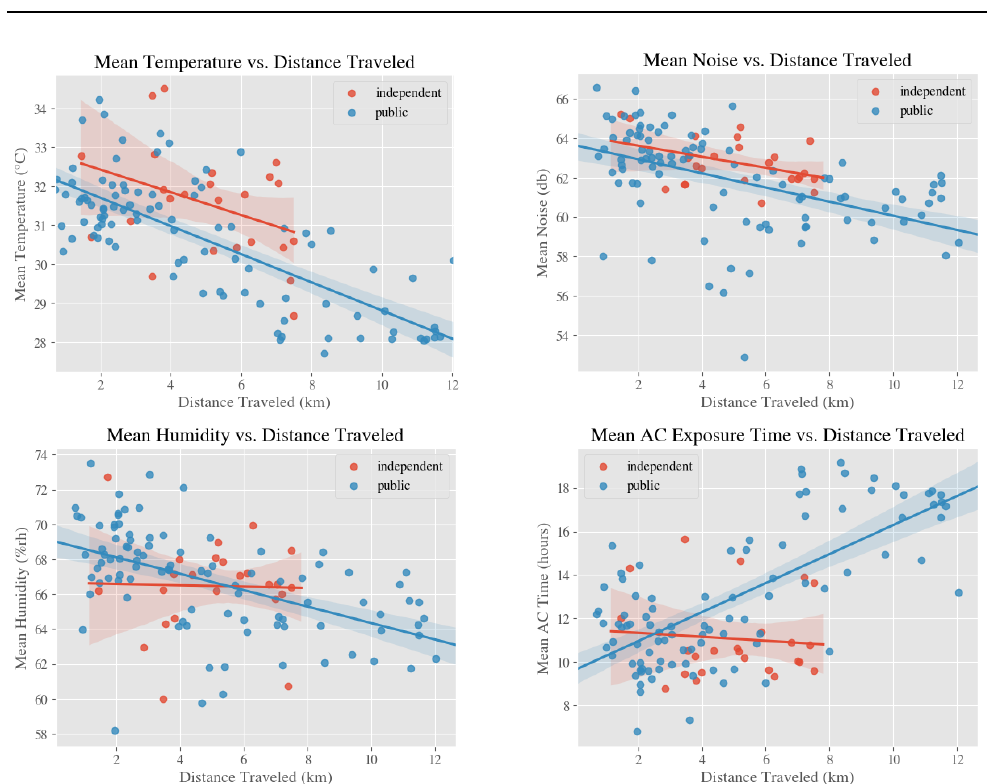
Figure 3. Relationships between environmental exposures and distance traveled between home and school with respect to whether the school is a independent or public